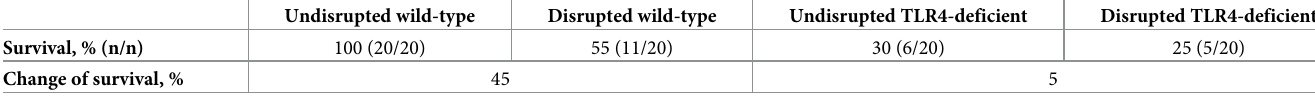
Table 1. The effect of gut microbiota disruption on survival in wild-type and TLR4-deficient mice after pneumococcal infection. Undisrupted wild-type Disrupted wild-type Undisrupted TLR4-deficient Disrupted